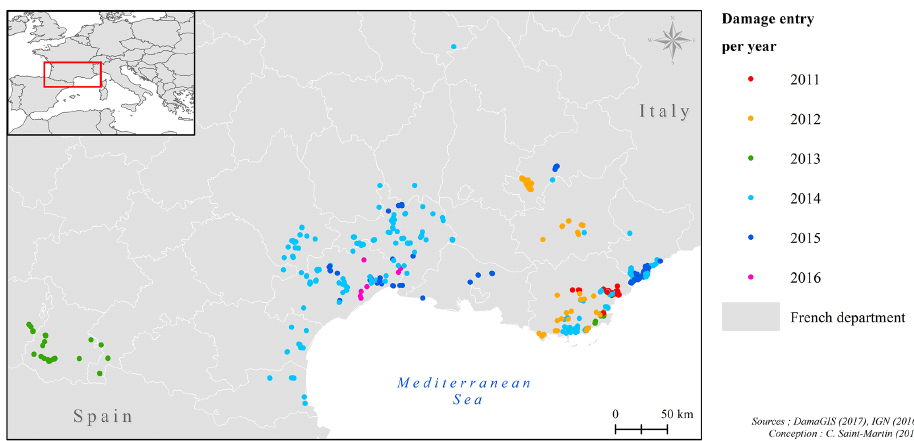
Figure 5. Spatial distribution of flood-related damage within the DamaGIS database.